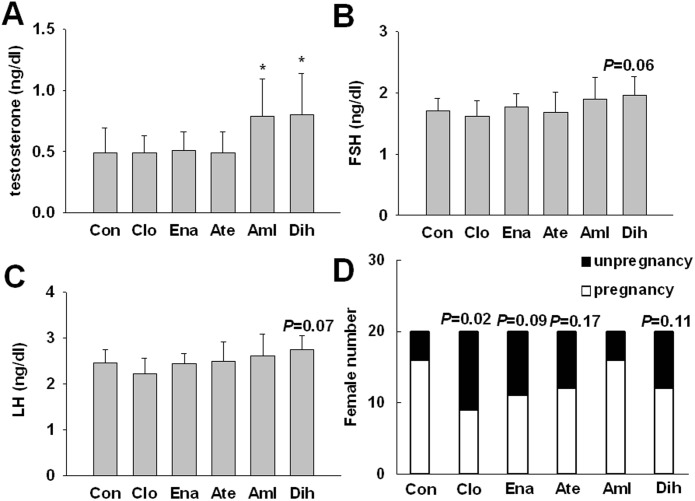
Effects of 3-month treatment of 5 different antihypertensive drugs on the sexual hormone levels and the conception rate of SHR.(A), (B) and (C), Data are shown as mean ± SD. Data are analyzed by ANOVA followed by dunnett t-testing. *P < 0.05, vs. Con. (D), every male SHR was put in a single cage with 2 female SD rats. After one week copulation, the conception rate of the female rats was recorded (D). Chi-square test is used to estimate the conception rate. SHR, n = 10, Female SD rats, n = 20. Abbreviation: Con, control; Clo, clonidine; Ena, enalapril; Ate, atenolol; Aml, amlodipine; Dih, dihydrochlorothiazide; FSH, follicle-stimulating hormone; LH. luteinizing hormone.